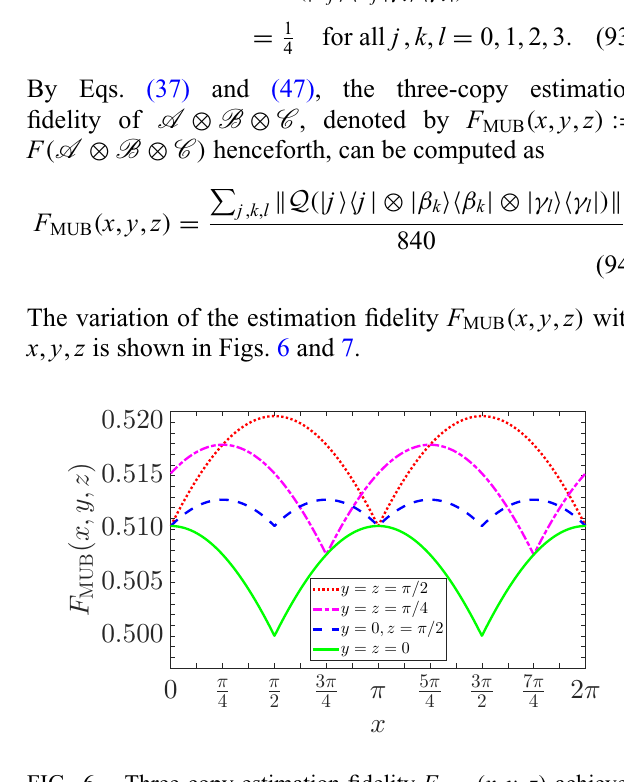
FIG. 6. Three-copy estimation fidelity F MUB ( x , y , z ) achieved by the product projective measurement based on a triple of MUB as determined in Eq.